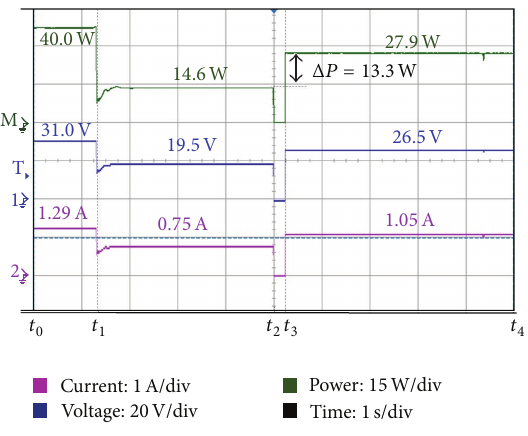
Figure 13: Experimental results: